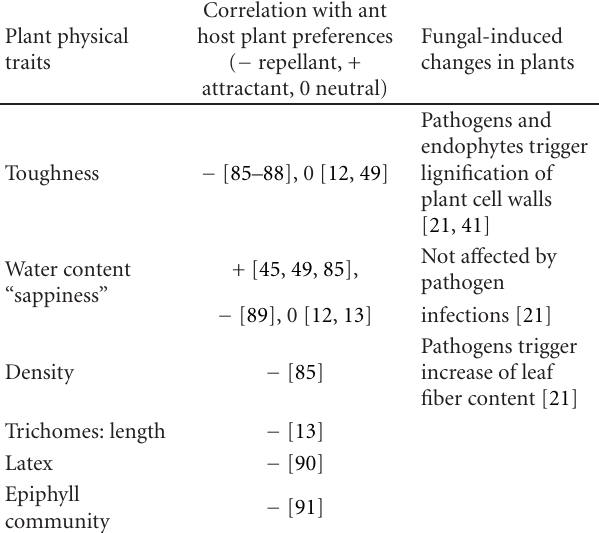
Table 3: A review of studies that correlate plant physical charac- teristics with ant foraging preferences, with additional observations of whether these plant traits change as a result of plant-fungal